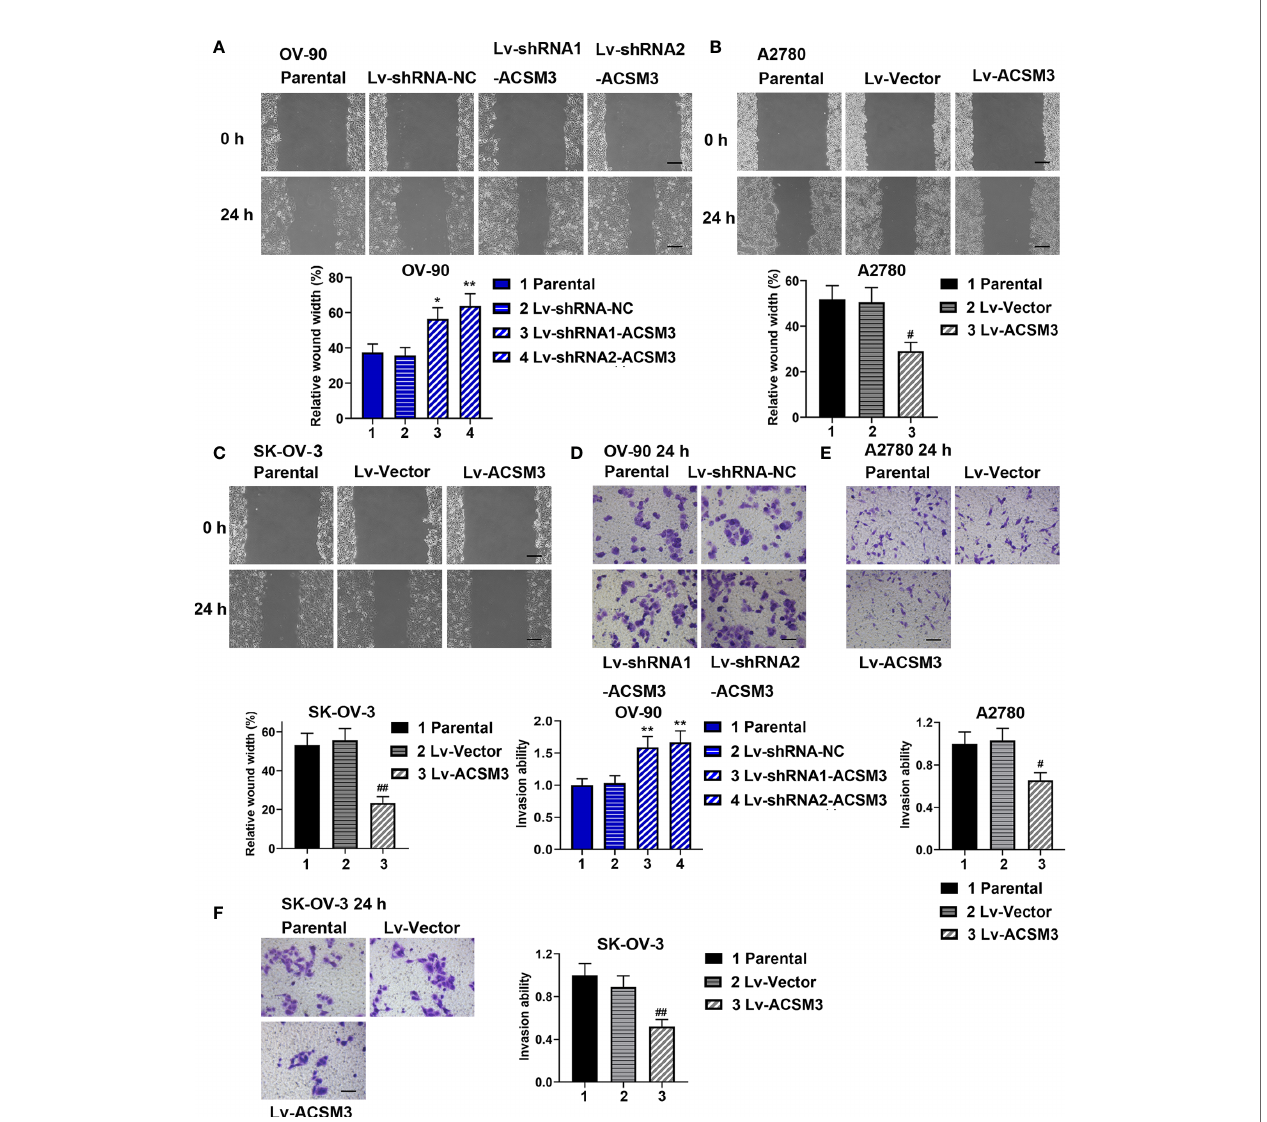
FIGURE 3 | Effects of ACSM3 on migration and invasion of ovarian cancer cells. OV-90 cells were infected with Lv-shRNA-ACSM3. A2780 or SK-OV-3 cells were infected with Lv-ACSM3. (A-C) Cell migration ability was measured by wound healing assay. Scale bar represented 200 m m (D-F) The ability of cell invasion was detected by transwell assay. Scale bar represented 100 m m. Measurement data were expressed as mean ± SD of three independent experiments. *p < 0.05, **p < 0.01 versus Lv-shRNA-NC; # P < 0.05, ## P < 0.01 versus